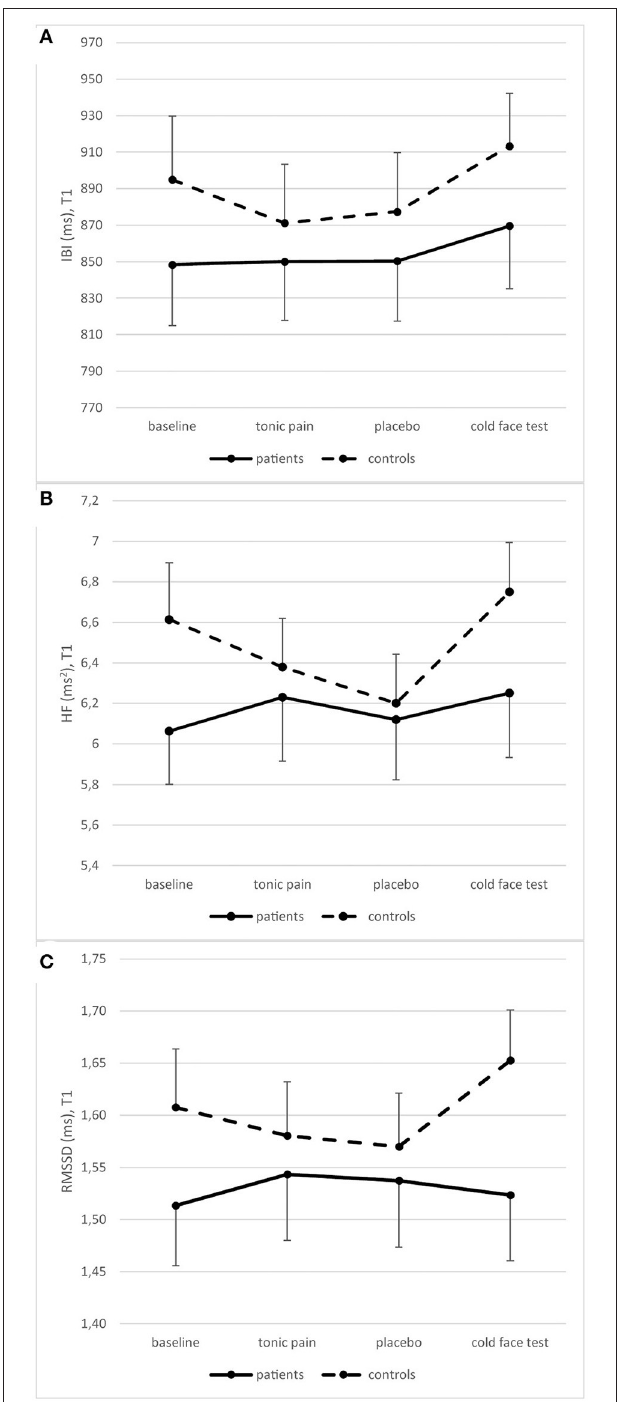
FIGURE 5 | Heart rate variability measured as IBI (A) , HF (B) , and RMSSD (C) in patients and controls at T1 (means and standard errors).